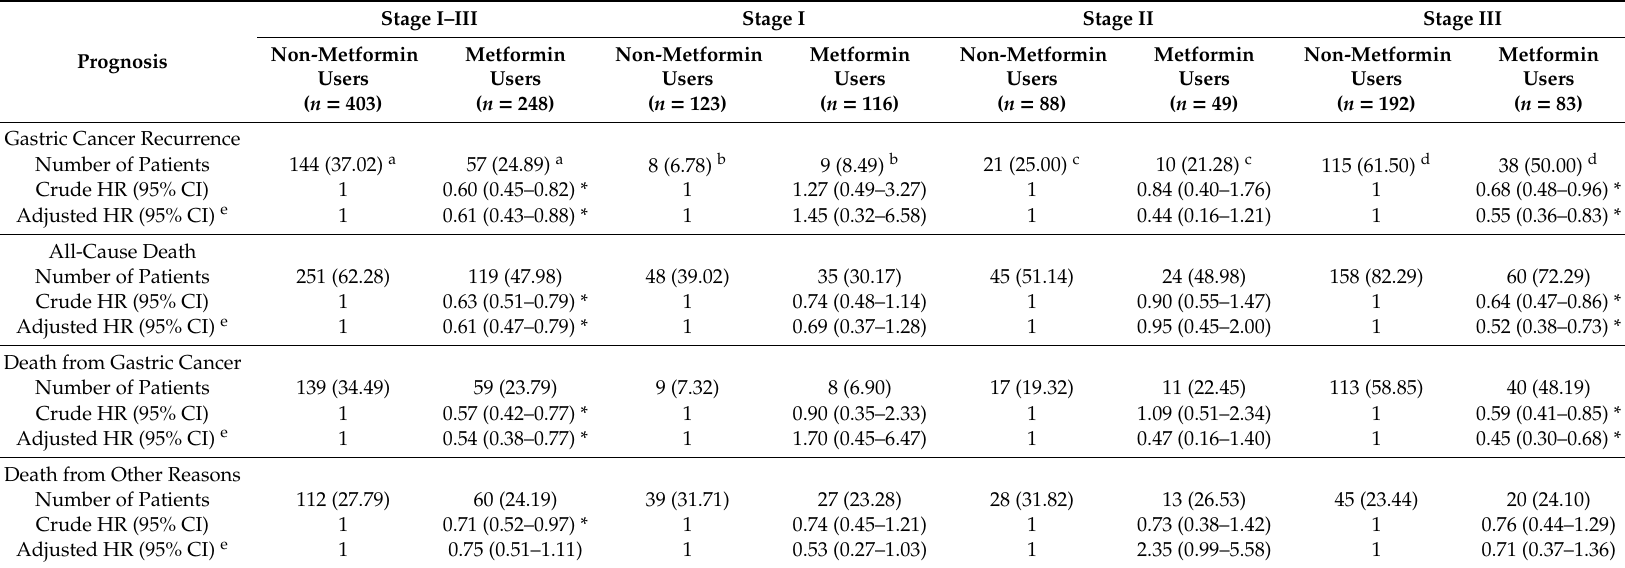
Table 2. Recurrence and death in patients with gastric cancer (GC) and diabetes mellitus (DM) treated with and without metformin, stratified by